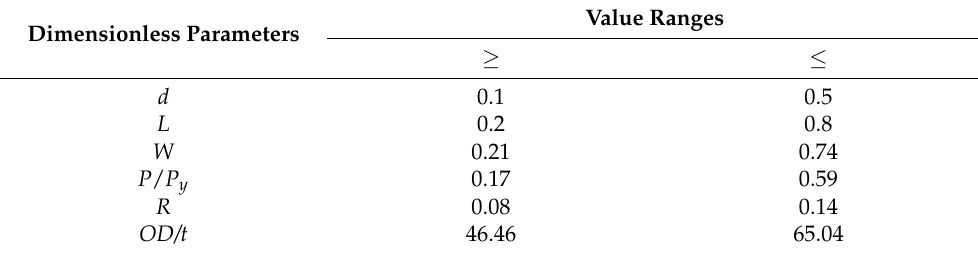
Table 7. Applicable range for dimensionless parameters.